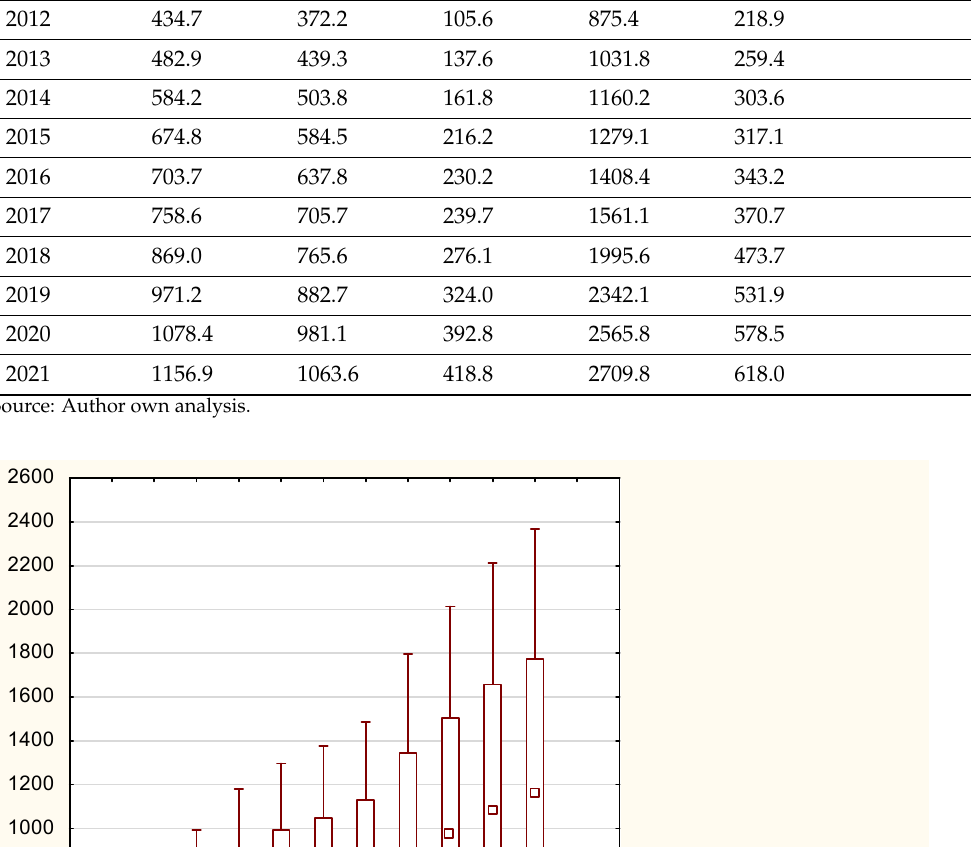
Table 3. Basic descriptive statistics for variability of bike road lengths in following years.